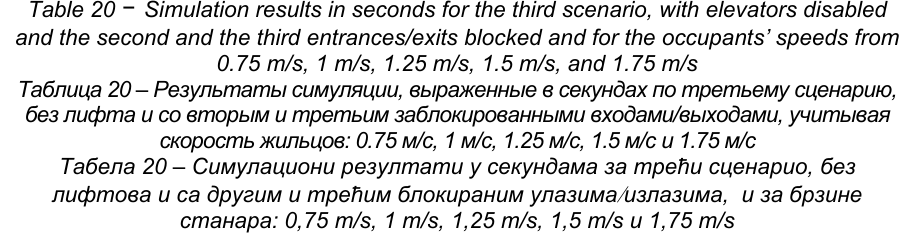
Table 20 – Simulation results in seconds for the third scenario, with elevators disabled and the second and the third entrances/exits blocked and for the occupants’ speeds from